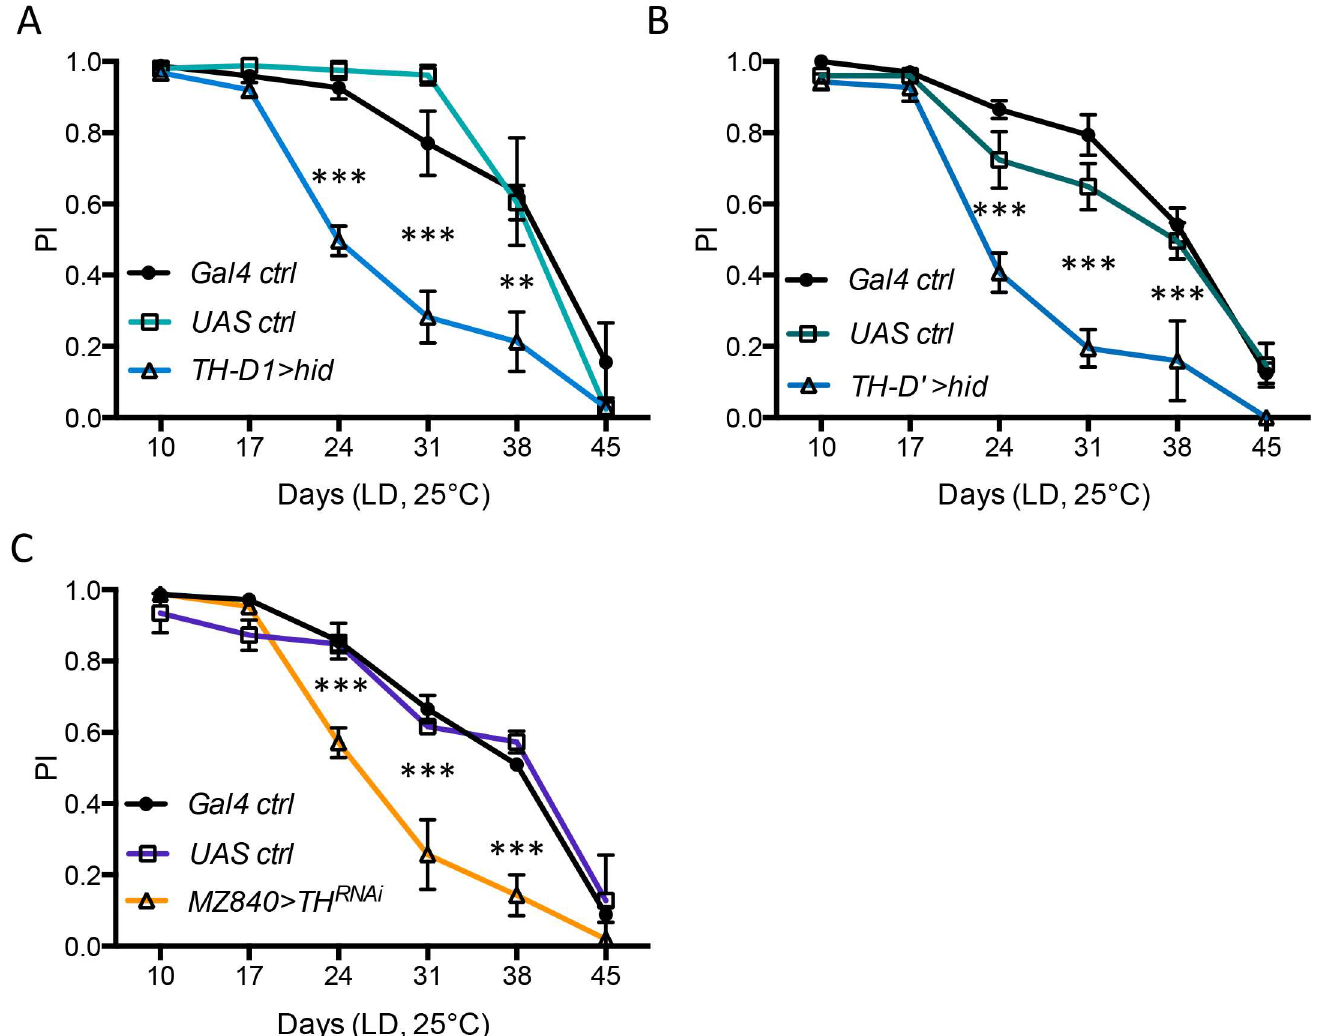
Fig 7. PPL1 dopaminergic neuron disruption accelerates ARLI. (A,B) Expression of the pro-apoptotic gene hid in dopaminergic neuronsof the PPL1, PPL2 and PPM3 clusters with TH-D1-Gal4 and TH-D’-Gal4 drivers accelerates ARLI in aging flies. (C) TH RNAi expressionusing MZ840-Gal4 that targets one pair of dopaminergic neurons(the MB-V1 in each PPL1 cluster) as well as non-dopaminergic brain cells similarly speededup SING decline with age. Data in panelsA and B are from 2 separate experiments, with 5 groupsof flies tested at each age for each genotype, the graphsshowing means and sem for these 5 groups. Panel C is an averageof 2 independentexperiments with the indicatedgenotypes.